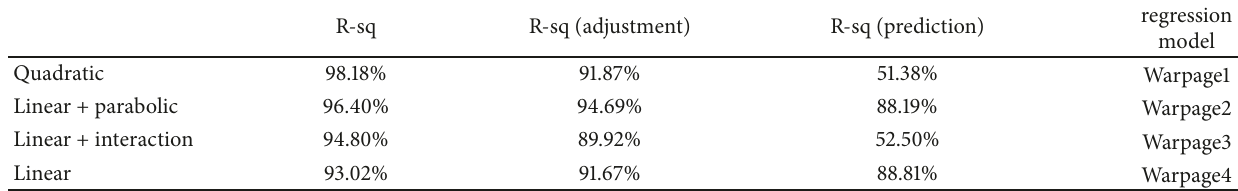
Table 10: Fitting results of the warpage using the four regression models.